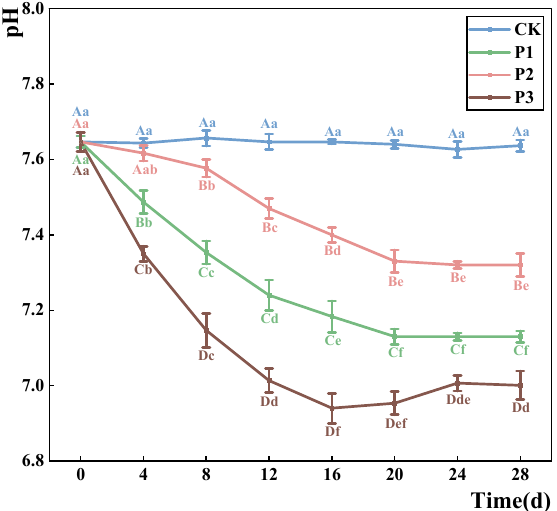
Figure 6. Soil pH with various soil bacteria. According to a one-way analysis of variance and the Duncan test, different capital letters indicate a significant difference ( p < 0.05) across different treatments. Different lowercase letters denote significant differences ( p < 0.05) between different timepoints applied to the same bacteria.